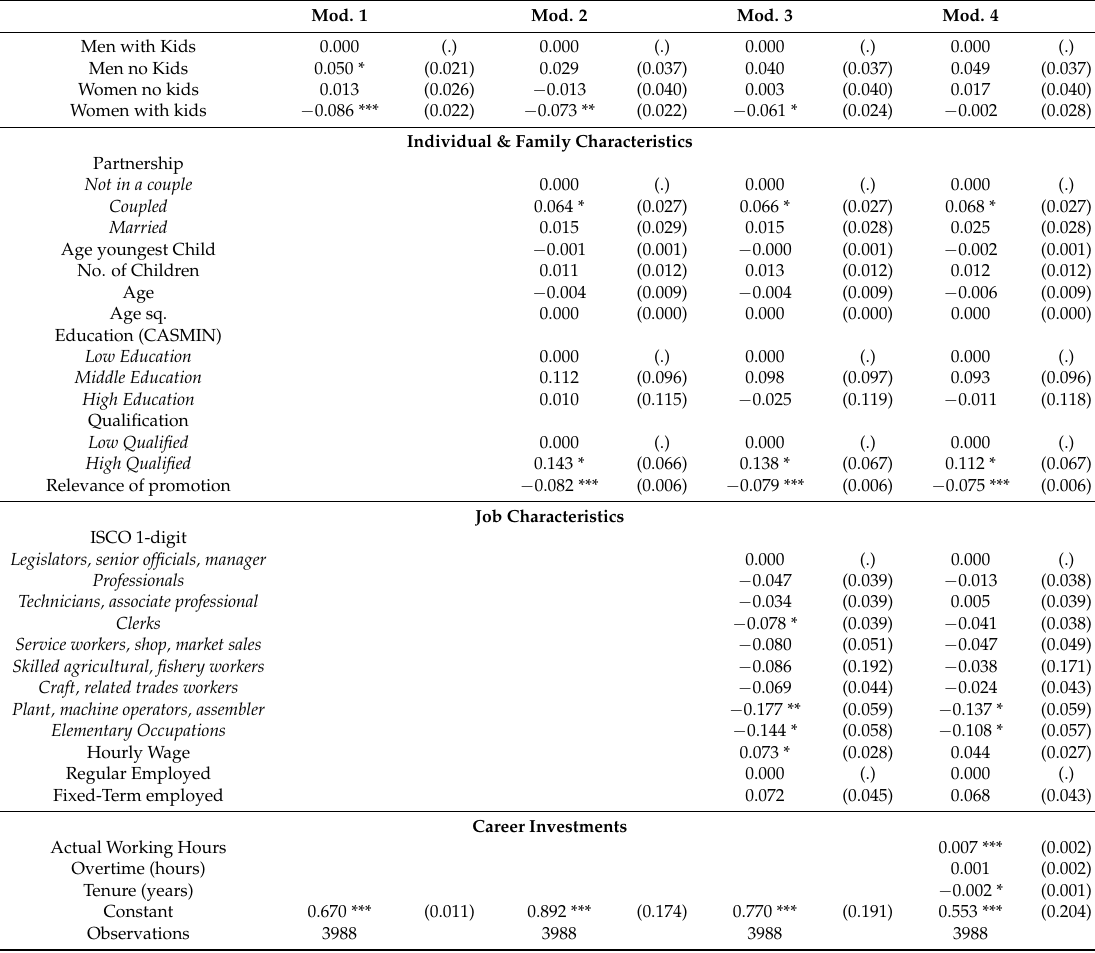
Table 4. Gender differences in claims-making, with only individual-level control variables (results of fixed-effects